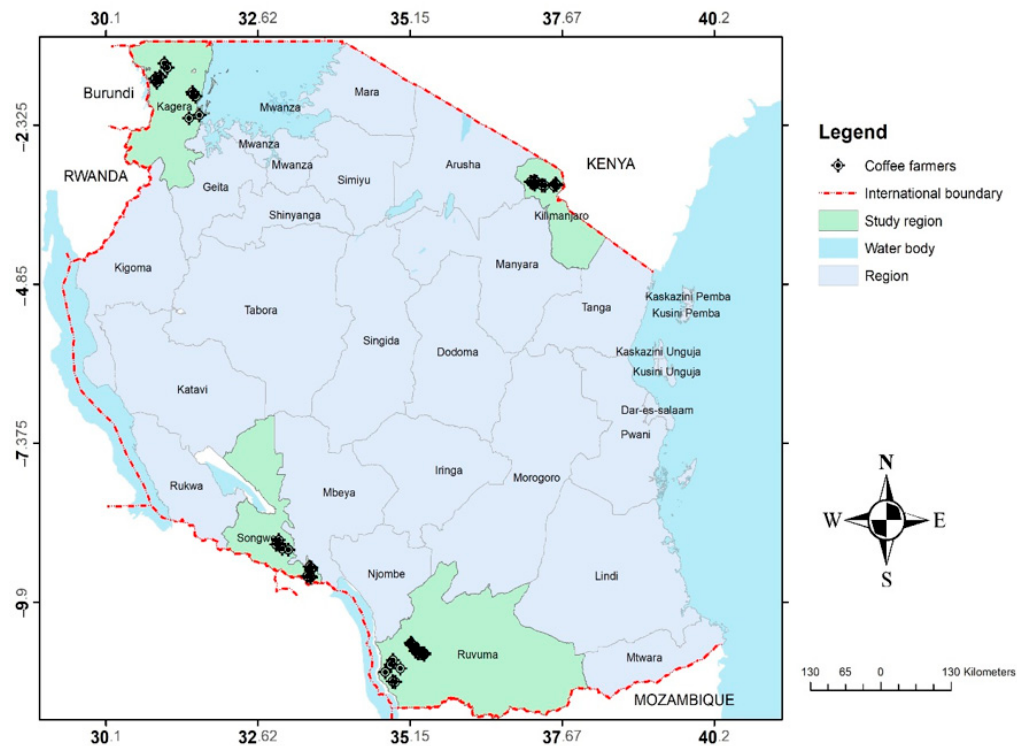
Figure 3. Map showing regions in Tanzania and the distribution of coffee farmers involved in the study. Source: sketched using coffee farmers’ household survey global positioning system (GPS) 2021 data.